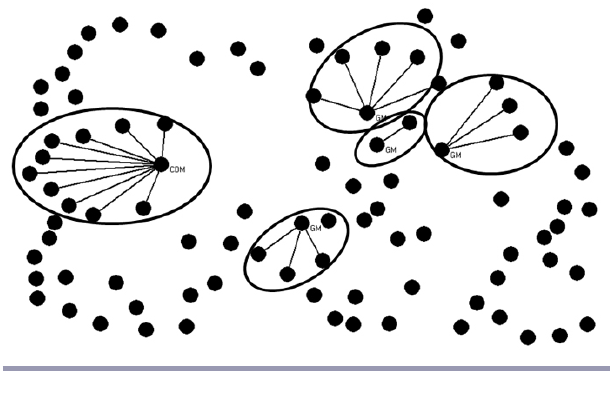
Fig. 7 . Landcare Group A interest clusters - water and bushfire.